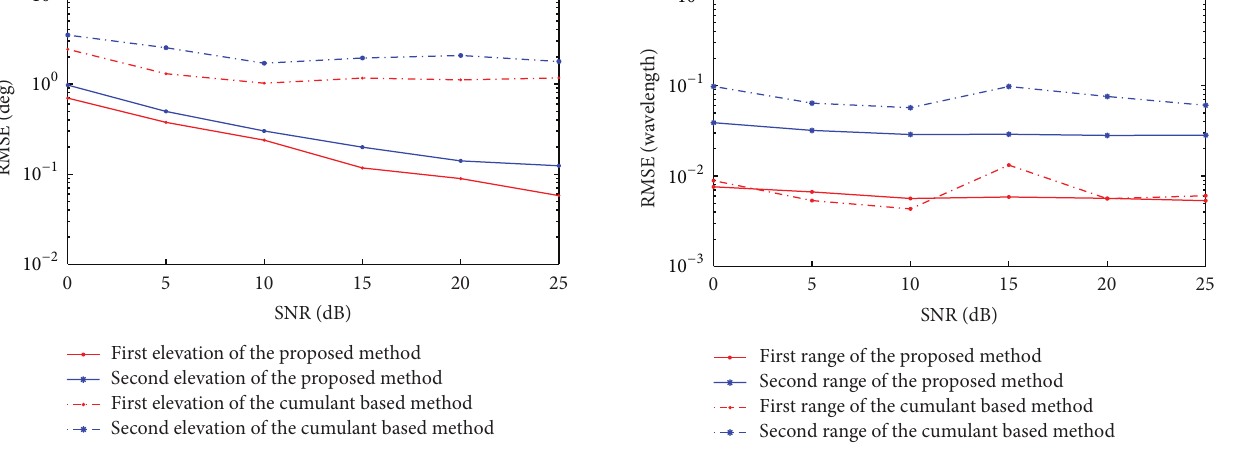
Figure 2: The RMSE of elevation estimations for two near-field sourcesusingtheproposedmethodandthecumulantbasedmethod versus SNR.